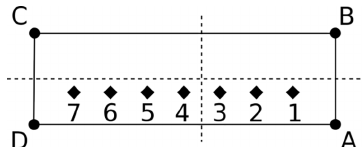
Figure 1. A L2 satellite pixel ABCD is divided into subpixels (dia- monds 1 to 7). Each subpixel is assigned to a L3 grid cell (indicated with the dashed boundaries) and the average and standard devia- tions are calculated (see text). In this example, subpixels 1–3 would be assigned to the lower-right grid cell and subpixels 4–7 would be assigned to the lower-left grid cell. The satellite pixel ABCD may have any orientation with respect to the L3